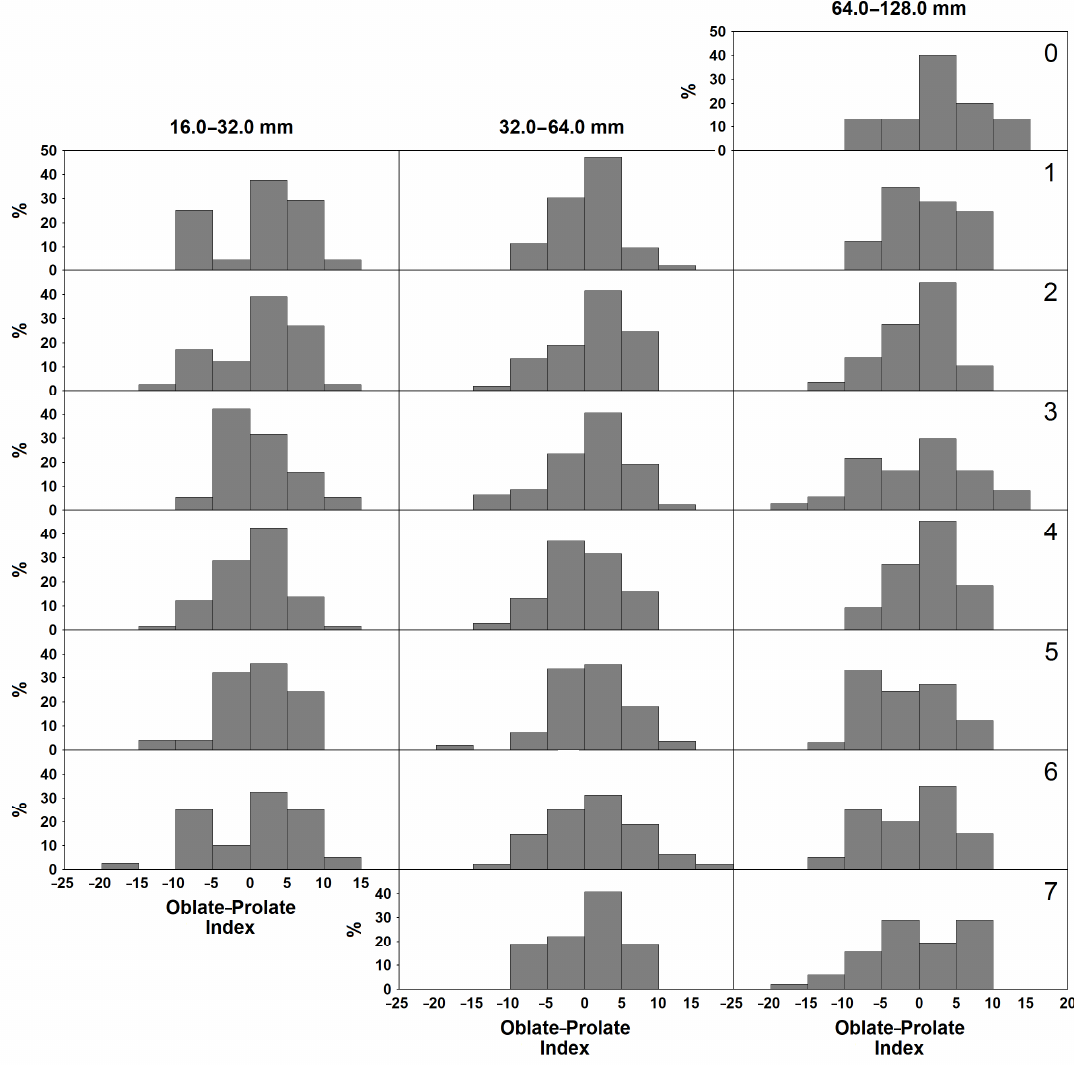
Figure 17. The frequency distribution of the Oblate–Prolate Index of gravels of Navilawa Monzonite within the 16.0–32.0, 32.0–64.0 and 64.0–128.0 mm fractions from Stations 0–8 along the Sabeto River of western Viti Levu, Fiji.